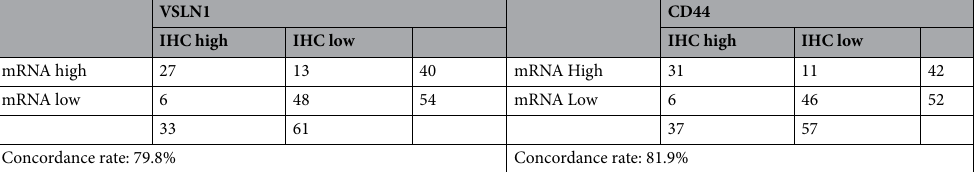
Table 3. Relationship between VSNL1 mRNA expression and VSNL1 protein expression, and for the relationship between CD44 mRNA expression and CD44 protein